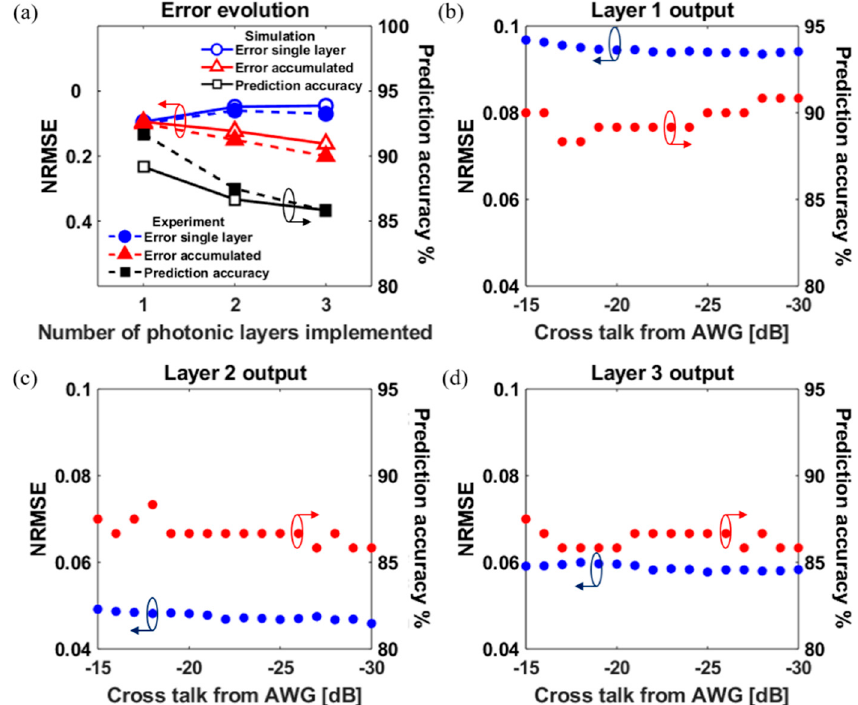
Figure 7. Error evolution: ( a ) Normalized root mean square error (NRMSE) versus the number of implemented photonic layers in simulation (solid line filled points) and experiment (dashed line open points), from single photonic layer (circles), the accumulation (triangles) and the corresponding prediction accuracy (squares). Crosstalk tuning: The induced error (blue circles) and the final prediction accuracy (red circles) versus the crosstalk from AWGs, recorded simulation results from ( b ) output of layer 1, ( c ) output of layer 2, and ( d ) output of layer 3.